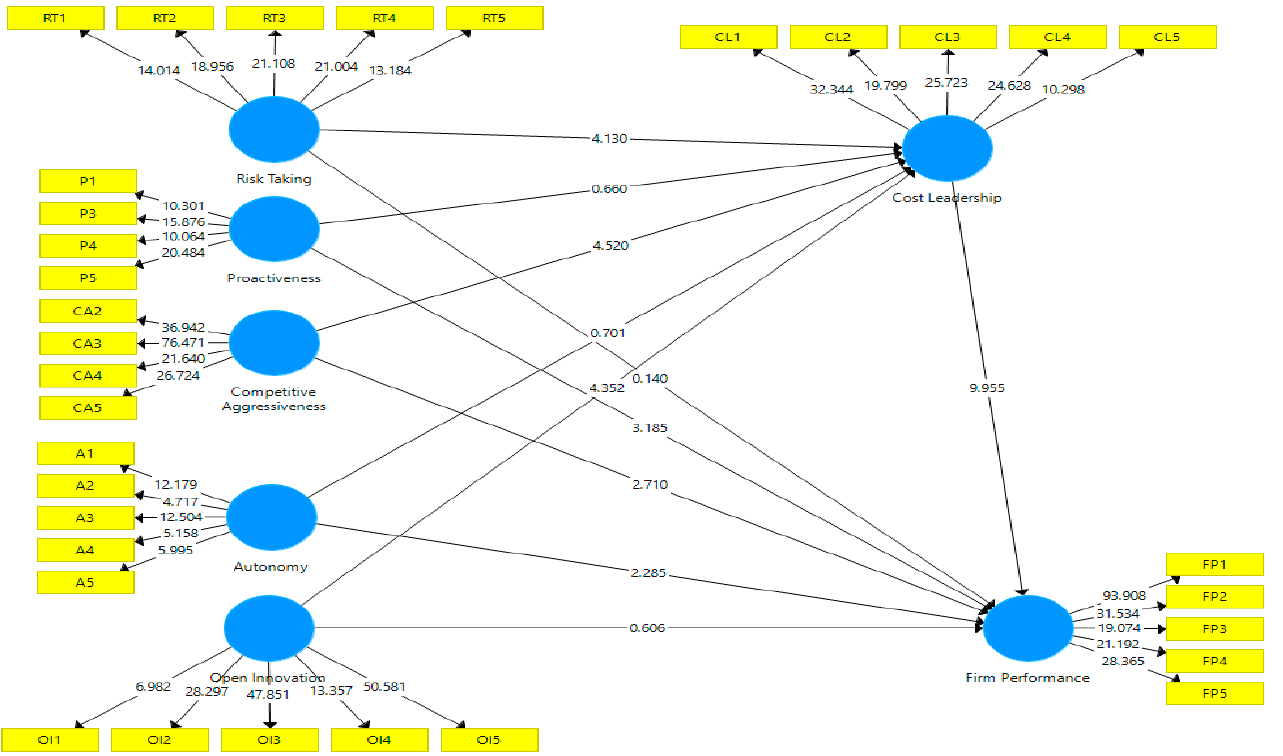
Figure 3. Structural Model (Direct